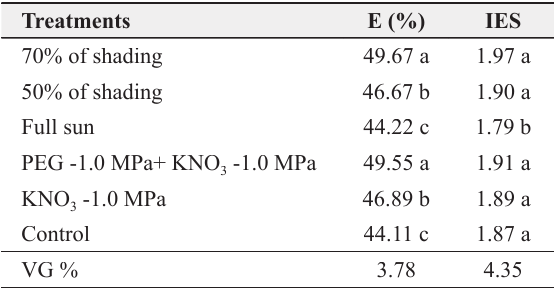
Emergence percentage (E) and index of emergence speed (IES) of Myracrodruon urundeuva Allemão seeds due to different levels of shading and different pre-osmotic conditioning treatments.